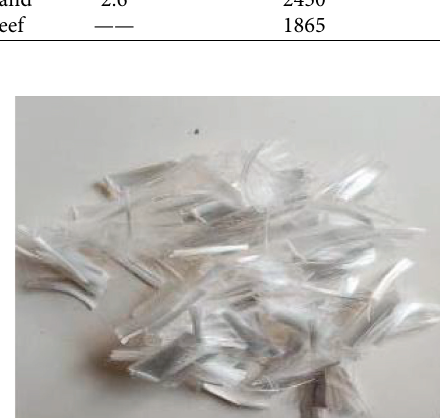
Figure 2: Modified polypropylene